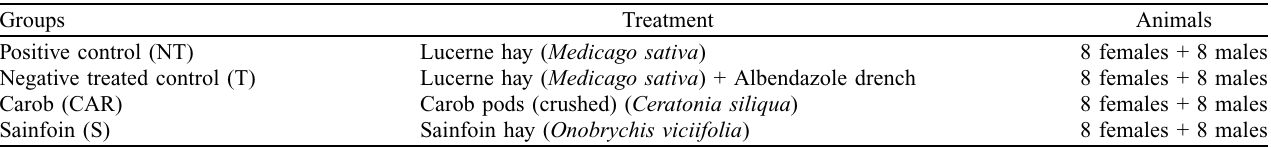
Table 1. Experimental design: animal diet regimes and/or anthelmintic treatment received according to the four different experimental groups (Total lambs n =